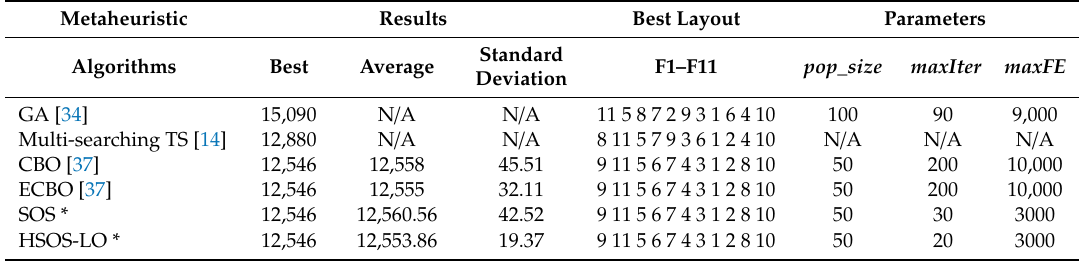
Table 4. Result comparison with previous research.